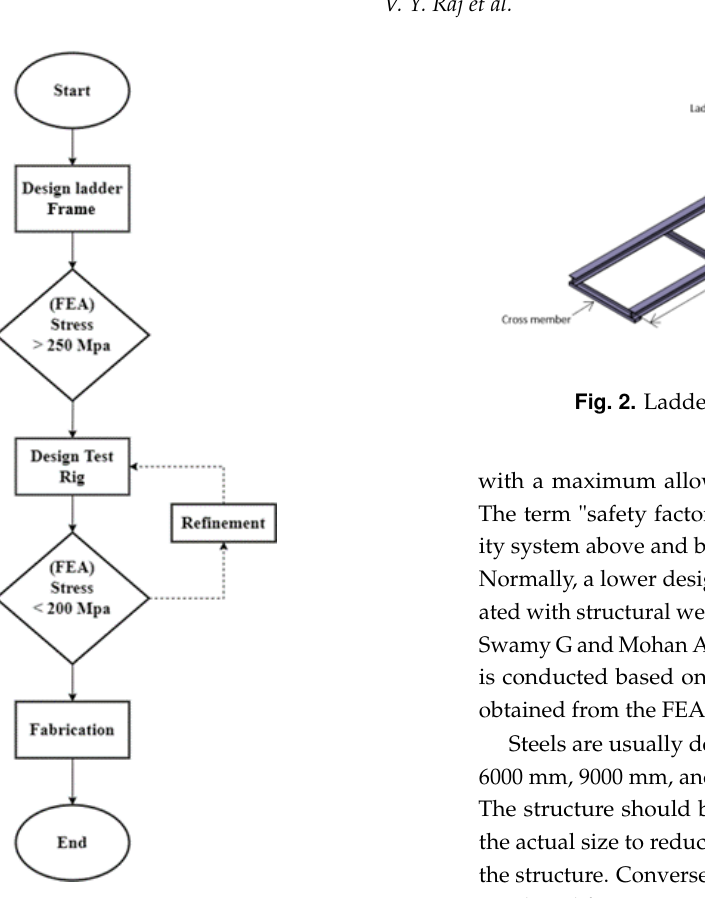
Fig. 1. Flow Chart.